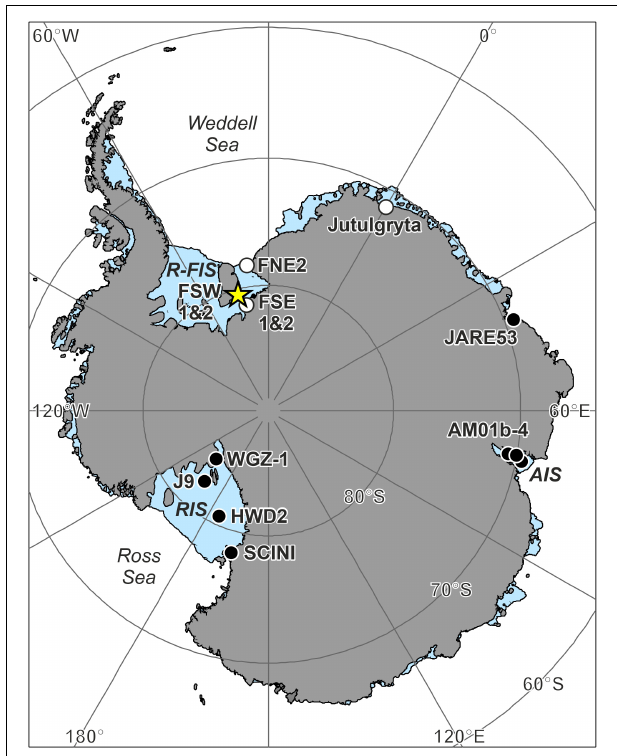
FIGURE 1 | Antarctic ice shelf borehole locations with seafloor images. Details for each location can be found in Table 1 . New records with life present from this study are marked with a star, boreholes where life was observed with a black circle and where no life was observed or reported with a white circle. R-FIS, Ronne-Filchner Ice Shelf; RIS, Ross Ice Shelf; AIS, Amery Ice